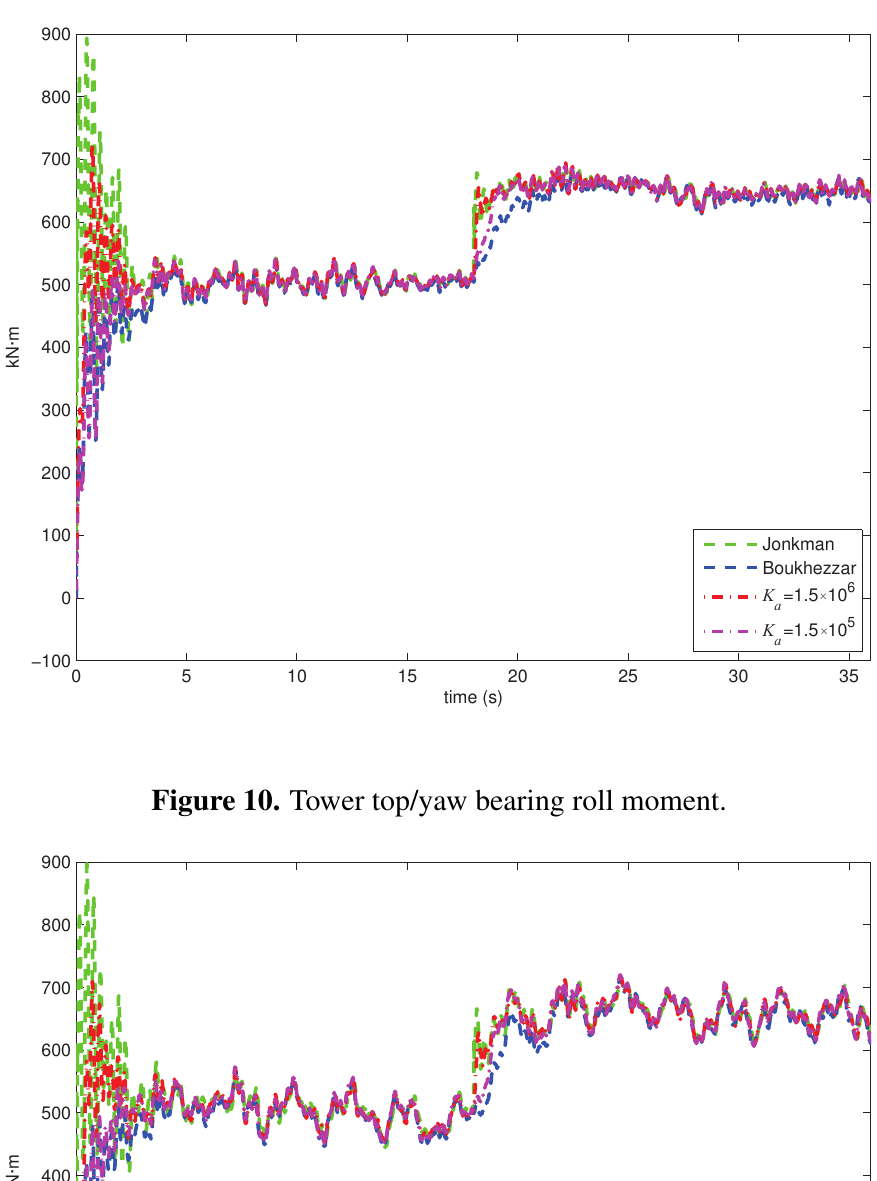
Figure 9. Drive shaft torsion.